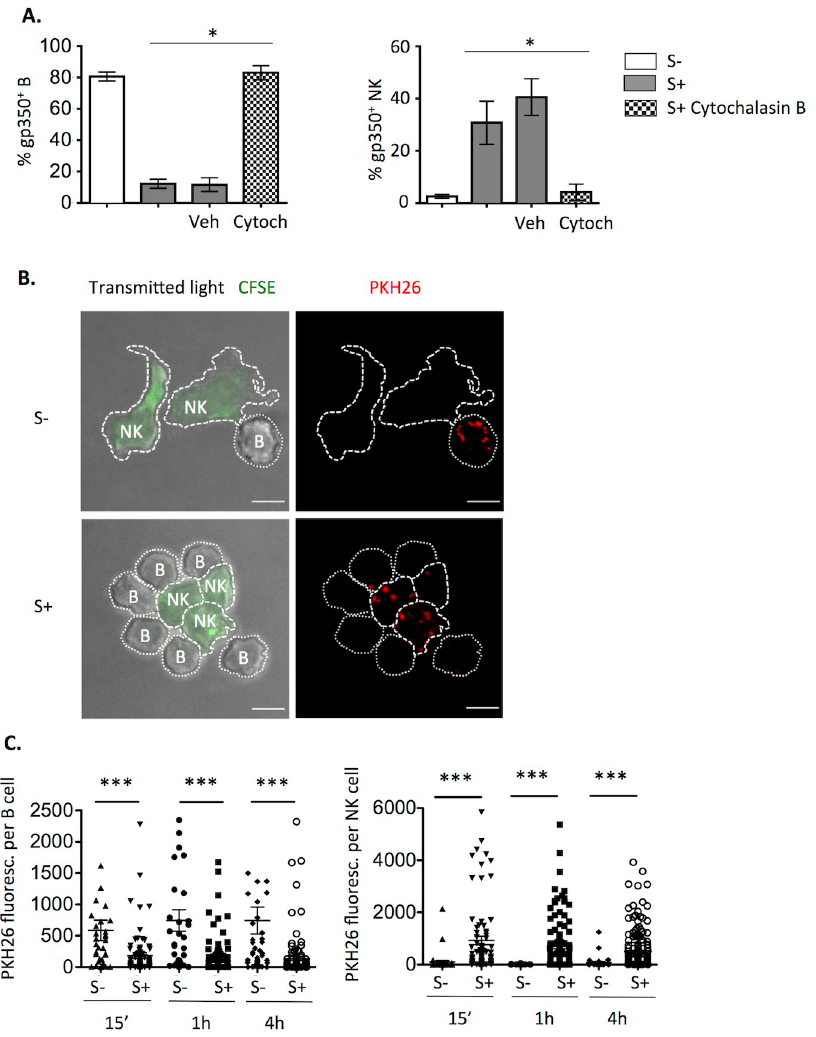
Fig 5. Transfer of B cell bound-EBV particles to NK cells involves contact. (A) B cells were coated with B95.8 VP, stained for gp350 and co-cultured with NK cells pre-treated for 2h with 20 μ g/ml of Cytochalasin B or the equivalent volume of vehicle (DMSO). Co-cultures were performed in the presence of EBV S- or S+ serum, with or without 20 μ g/ ml of Cytochalasin B or vehicle for 4h. The proportions of gp350 + B (left) and NK cells (right) corresponding to four experiments are shown. Statistical analysis was performed with Friedman test with Dunn’s multiple comparison test. ( B-C) B cells were coated with PKH26-stained B95.8 VP, cultured with CFSE-stained NK cells and EBV S- or S+ for 15min, 1h or 4h, adhered onto coverslips and analyzed by confocal microscopy. ( A) Images of Maximum Intensity of the stack of the EBV S- (top) or S+ (bottom) conditions at 15 min. Scale bar: 5 μ m. Data are representative of three experiments. ( B) Quantification of total PKH26 fluorescence per B (left, 31–158 cells per condition) or NK cell (right, 34–116 cells per condition) from two different experiments. Statistical analysis was performed with Mann-Whitney U